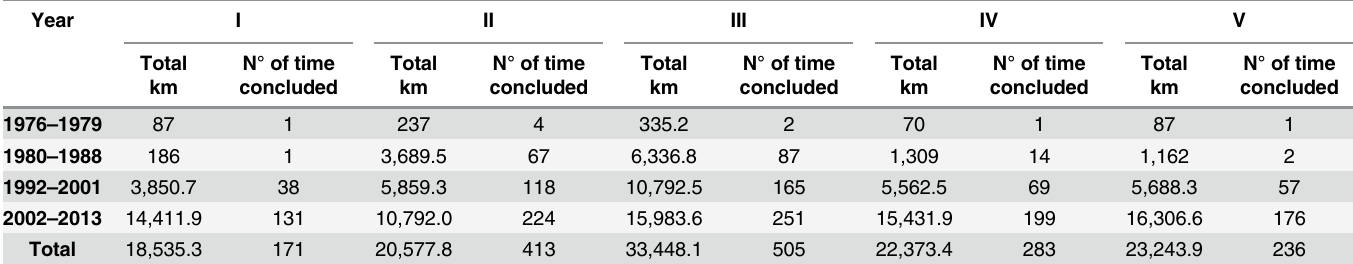
Table 1. Total kilometer of beach surveyed and the number of times that beach survey was concluded in each area from 1976 to 2013. I = 84km; II = 51km; III = 63km; IV = 70km; V = 87km. Year